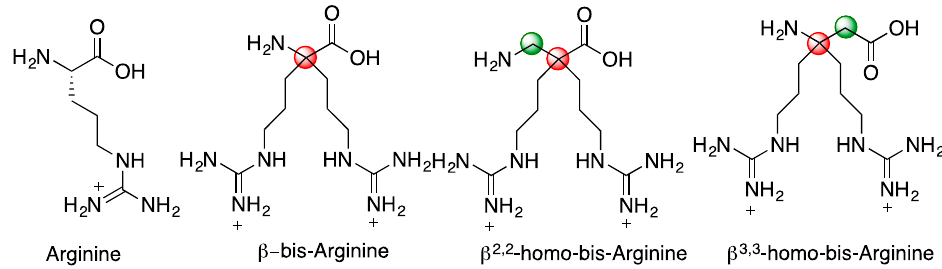
Figure 1. Bis-disubstituted-arginine analogues.